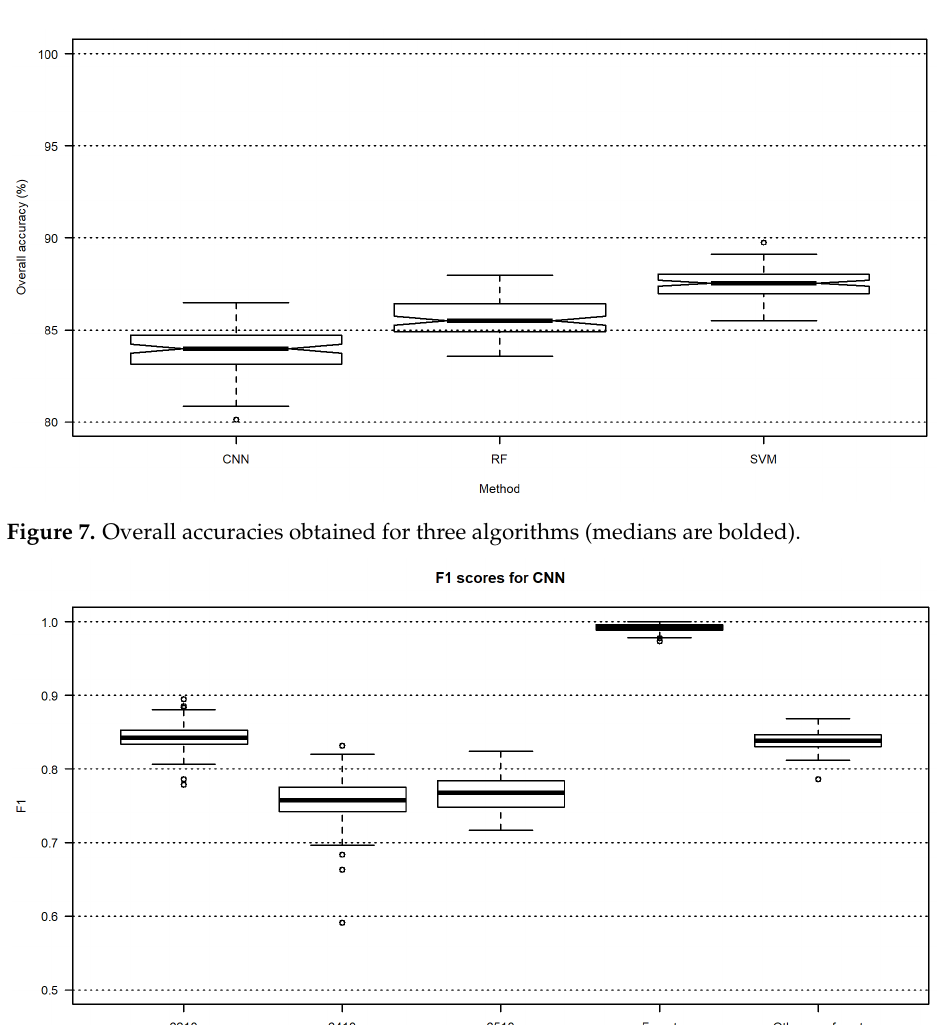
Remote Sens. 2023 , 15 , x FOR PEER REVIEW